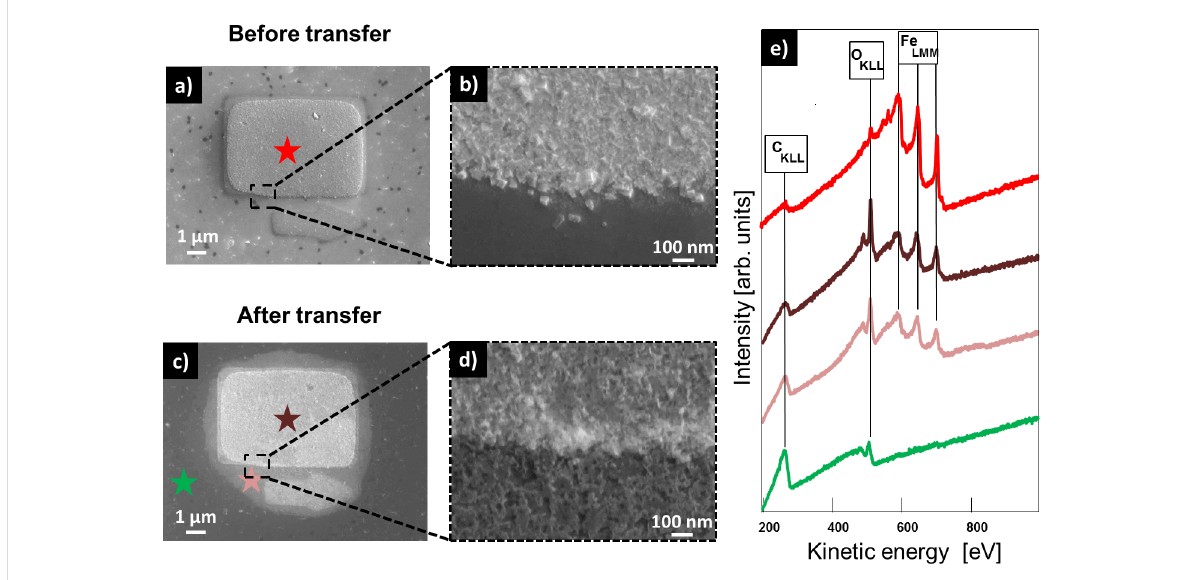
Figure 4: Transfer of a CNM with a Fe structure on top onto a SiO 2 sample. (a) SEM image of a Fe structure fabricated with EBID on a TPT SAM on Ag(111)/mica (beam parameters 15 kV, 400 pA, electron dose: 0.93 C/cm 2 , and AG time: 4 h 5 min). (b) Blowup image of the structure depicted in (a). (c) SEM image of the Fe structure depicted in (a) after the transfer to bulk SiO 2 . (d) Blowup image of the structure depicted in (c). (e) Local AES spec- tra recorded at the positions indicated with the correspondingly colored